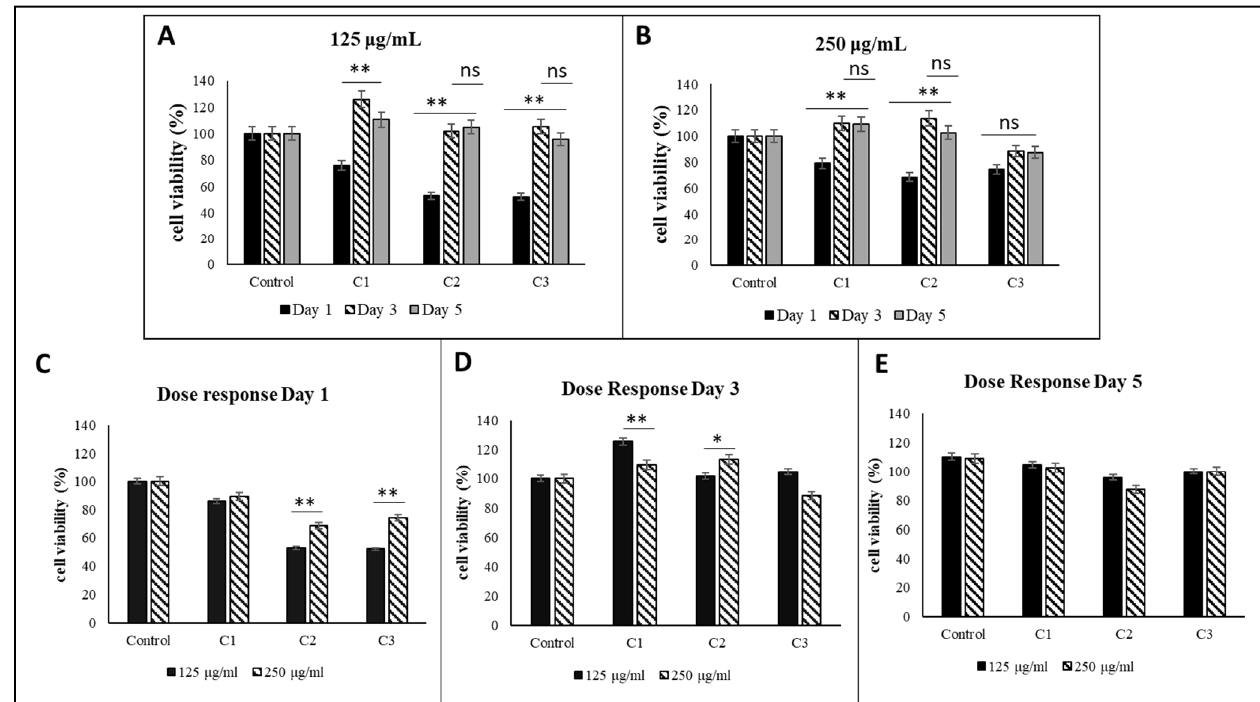
Figure 8. Results of cellular vitality–mitochondrial activity of biomaterials C1, C2, C3. ( A , B ) present differences among groups at low ( A ) and high ( B ) concentrations, while ( C , D ) present differences at day 3 ( C ) and day 5 ( E ) of cell culture. ( p < 0.05 *, p < 0.01 **). (* p < 0.05, ** p < 0.01).